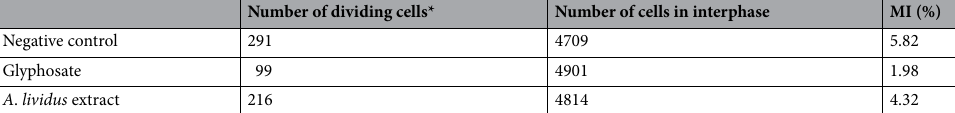
Number of dividing cells* Number of cells in interphase MI (%) Negative